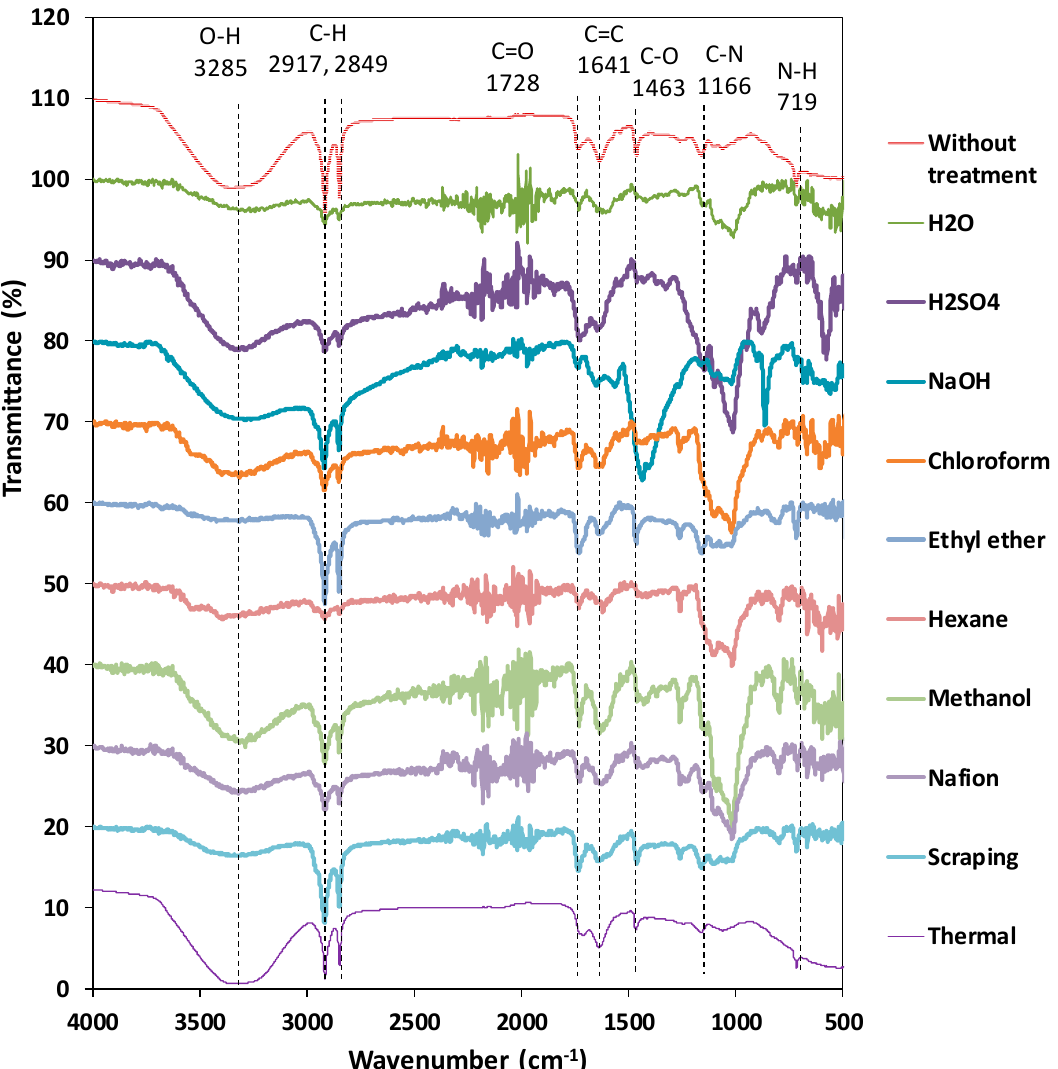
Figure 3. Fourier-transform infrared spectroscopy (FTIR) spectrum of the several treatments of the bio-membrane: Without Treatment, Immersion (H 2 O, H 2 SO 4 , NaOH), Clean-up (Chloroform, ethyl ether, Hexane, methanol), Polymeric Coating (Nafion), Scraping and Thermal.